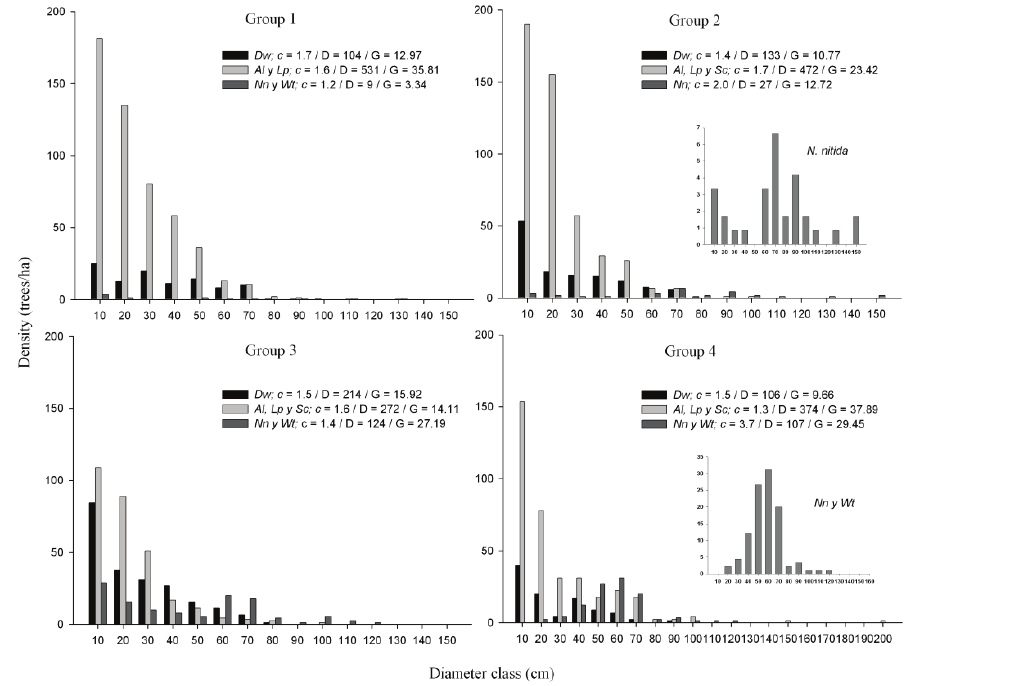
Figure 5. Diameter structure of the principal tree species grouped according to their shade tolerance for each forest group. Inset in groups 2 and 4 show the diameter structure of the shade-intolerant species. Abbreviations of species in Table 1: c = shape parameter of the